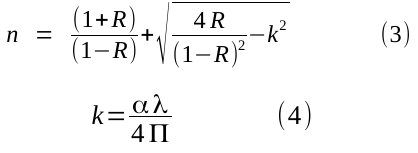
Figure 2. Film thickness of CeS